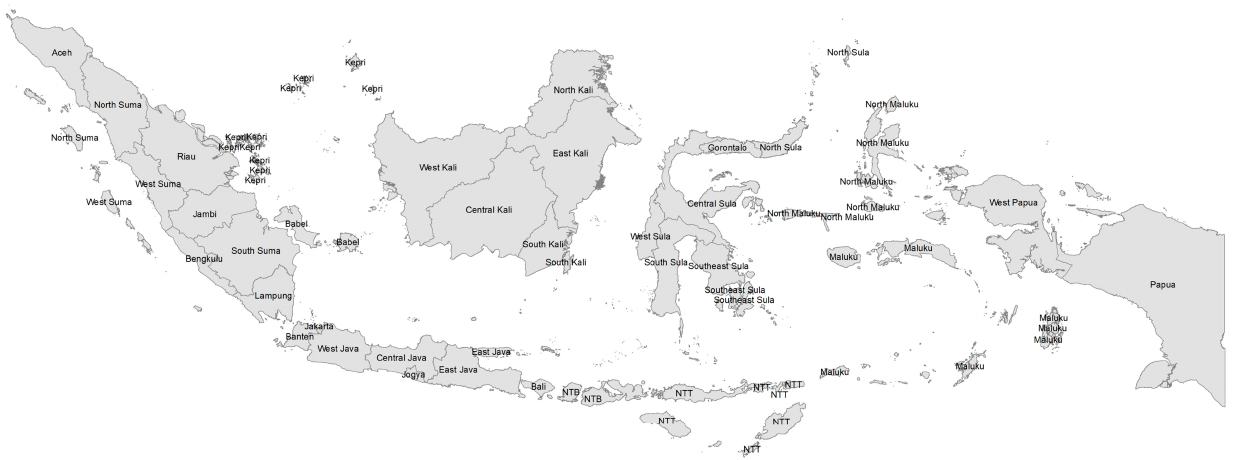
Figure 1. Map of Indonesia by province. Note: Suma = Sumatera, Kepri = Riau Islands, Sula = Sulawesi, Kali = Kalimantan, NTB = West Nusa Tenggara, NTT = East Nusa Tenggara. We divided the provinces into five regions, including Sumatera, Java/Bali, Kalimantan, Sulawesi, and Papua/Maluku/Nusa Tenggara. Java/Bali is the most developed and Papua/Maluku/Nusa Tenggara is the least developed. We obtained the shapefile from the Indonesian Information and Geospatial Agency and created the map in ArcMap 10.